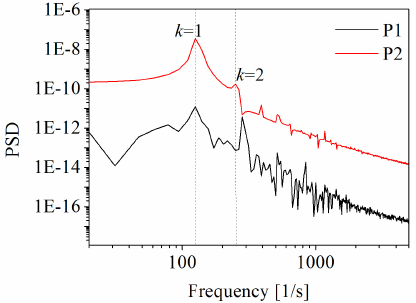
( b ) P2 (0, 0.5 R , − 1.0 R ). R ) and ( b ) P2 (0, 0.5 × R , − 1.0 × R ).